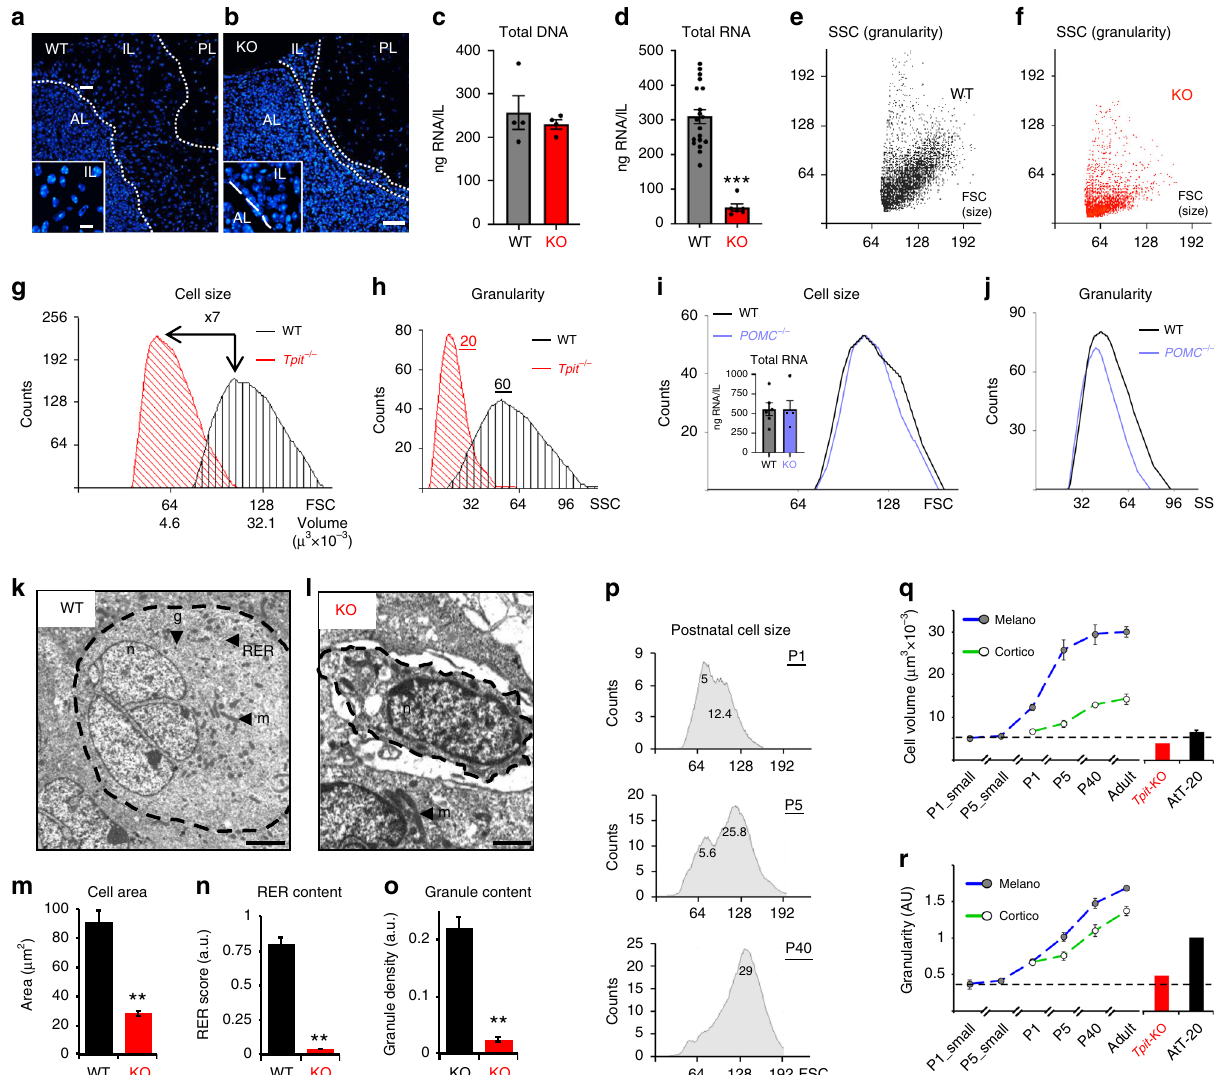
Fig. 1 Tpit is required for postnatal maturation of pituitary POMC cells. a – o Reduced cell size and organelle content in Tpit-de fi cient pituitaries. a , b Nuclear staining (Hoechst) of pituitary sections from adult WT a and KO b mice. Demarcations between pituitary lobes (anterior: AL, intermediate: IL, posterior: PL) are indicated by dashed lines. Higher magni fi cation insets show increased nuclear density in mutant IL. Scale bars: 10 µ m a , 20 µ m b . c , d Quantitation of total genomic DNA c and RNA d contents in WT and Tpit KO IL (each dot represents independent measure). e – h Flow cytometry (FACS) analysis of WT e and Tpit-KO f IL cells showing forward (FSC) vs. side (SSC) scatter that re fl ect cell size and granularity (organelle content), respectively. Distribution of cell size g and granularity h for each genotype. i , j RNA content (histogram) and FACS analyses of POMC -de fi cient IL cells (purple) indicate normal RNA content, size i and slightly reduced granularity j . k – o Ultrastructure analyses con fi rm cell size and organelle content defects in Tpit -de fi cient IL. k , l Electron micrographs of sections from WT k or KO l adult mouse pituitaries. WT cells k are rounded (dashed line), contain dense-cored secretory granules (g), mitochondria (m), and some rough endoplasmic reticulum (RER). Mutant cells l are smaller, with little cytoplasm and organelles (mitochondria dominate) and have a stellate appearance (not rounded). Scale bar in k = 2 µ m, in l = 1 µ m. n = nucleus. m – o Quantitation of cell area m , RER content n and granule density o in WT or KO IL cells. Data are presented as means ( n = 4 mice) ± SEM. p – r Pituitary POMC cells develop into secretory factories postnatally. p Melanotrope cell size changes after birth. FACS pro fi les showing FSC distribution of IL GFP-positive cells from POMC-EGFP mice. Numbers indicate calculated cell volumes ( µ m 3 x 10 − 3 ). q , r Summary of size q and granularity/organelle content r changes in postnatal IL melanotropes ( fi lled circles) and AL corticotropes (empty circles). Inferred progression of cell size and granularity in melanotropes (blue) and corticotropes (green) between days P1 and P90 (adult). Size and granularity of Tpit-KO cells remain at the P1 stage (red). Compared to controls using bilateral Student ’ s T -test with unequal variances: * P < 0.05, ** P < 0.005, *** P <